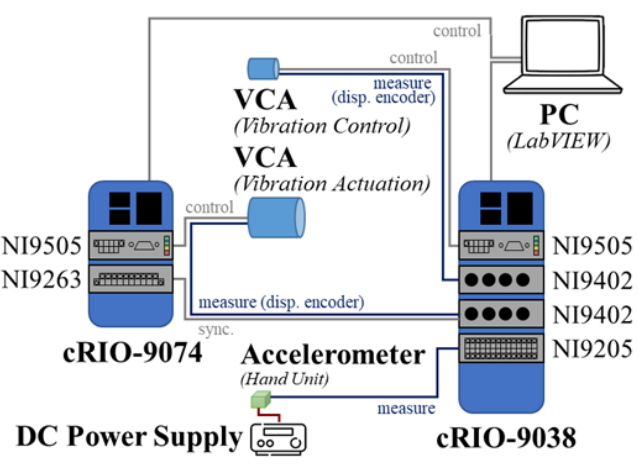
Figure 3. Schematic of sensor and actuator connection for the vibration testbed.